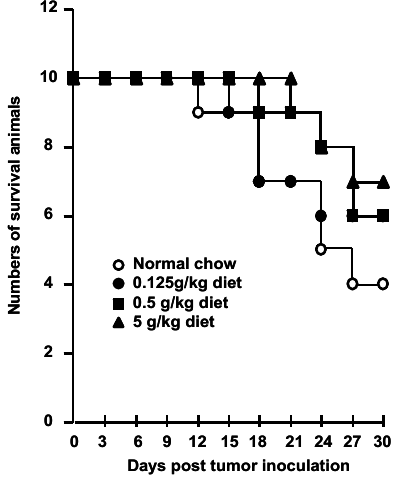
Figure 5. Administration of F. pinicola ethanol extract in S-180 tumor-bearing mice prolonged the survival time of the mice. Mice were pre-treated with a diet supplemented with different doses of F. pinicola ethanol extract as indicated for 3 days. Solid-type sarcoma 180 was subcutaneously injected in mice on day 0. The indicated amounts of F. pinicola ethanol extract were supplied for 27 consecutive days. Survival times of the S-180 tumor-beaing mice were recorded after after tumor inoculation. Results are expressed as the numbers of survival animals, n =